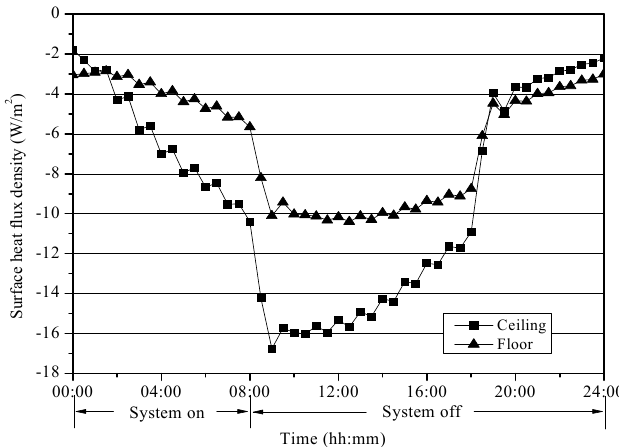
Figure 5. Heat flux density variation trends of cooling surface on 10 July.